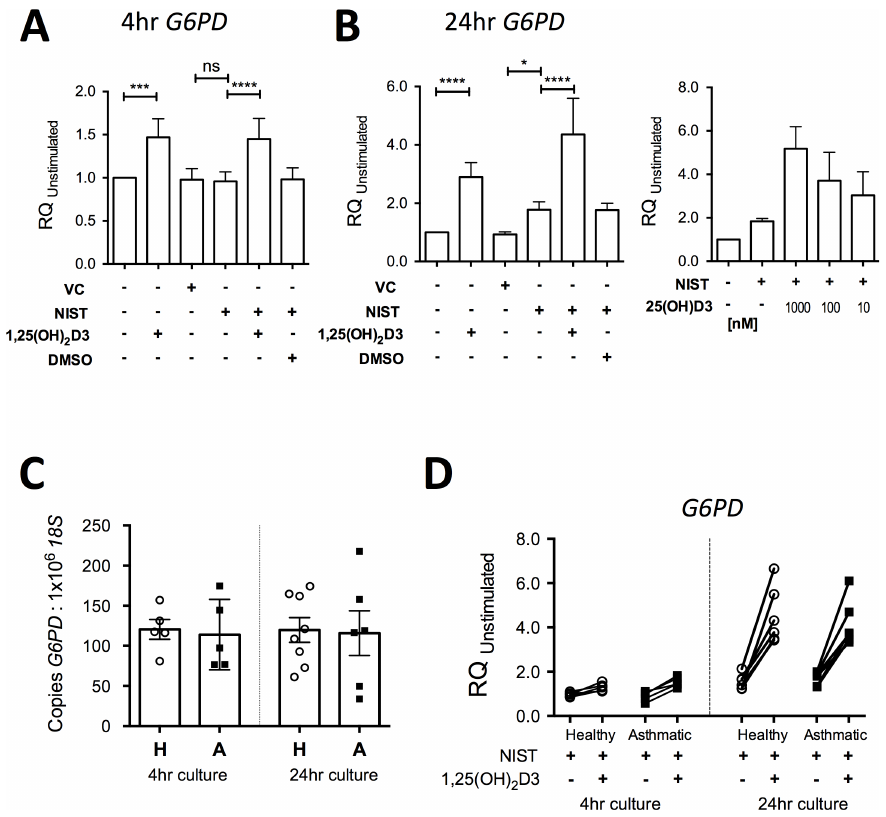
Fig 7. Capacity of vitamin D to enhance primary HBEC expression of G6PD . (A) Expression of G6PD in 4 hour cultures of primary HBECs stimulated with 50 μ g/ml NIST with/without 100nM 1,25(OH) 2 D3 (n = 6). (B) Expression of G6PD in 24 hour cultures of primary HBECs stimulated with 50ug/ml NIST with/without 100nM 1,25(OH) 2 D3 (n = 6) or a concentration series of 25(OH)D3, n = 5. (C) Expression of G6PD as measured by qPCR relative to 18S in unstimulated 4 hour and 24 hour HBEC cultures. H, Healthy donor HBECs; A, Asthmatic donor HBEC cultures. 4hr healthy, n = 5; 4hr asthmatic, n = 5; 24hr healthy, n = 8; 24hr asthmatic, n = 6. (D) Induction of G6PD by 50 μ g/ml NIST in the presence / absence of 100nM 1,25(OH) 2 D3 in 4 hour and 24 hour cultures of HBECs from healthy and asthmatic donors. 4hr healthy, n = 5; 4hr asthmatic, n = 5; 24hr healthy, n = 6; 24hr asthmatic, n = 6. Statistical significance as follows: (cid:3) , p (cid:20) 0.05; (cid:3)(cid:3) , p (cid:20) 0.01; (cid:3)(cid:3)(cid:3) , p (cid:20) 0.001; (cid:3)(cid:3)(cid:3)(cid:3) , p (cid:20)